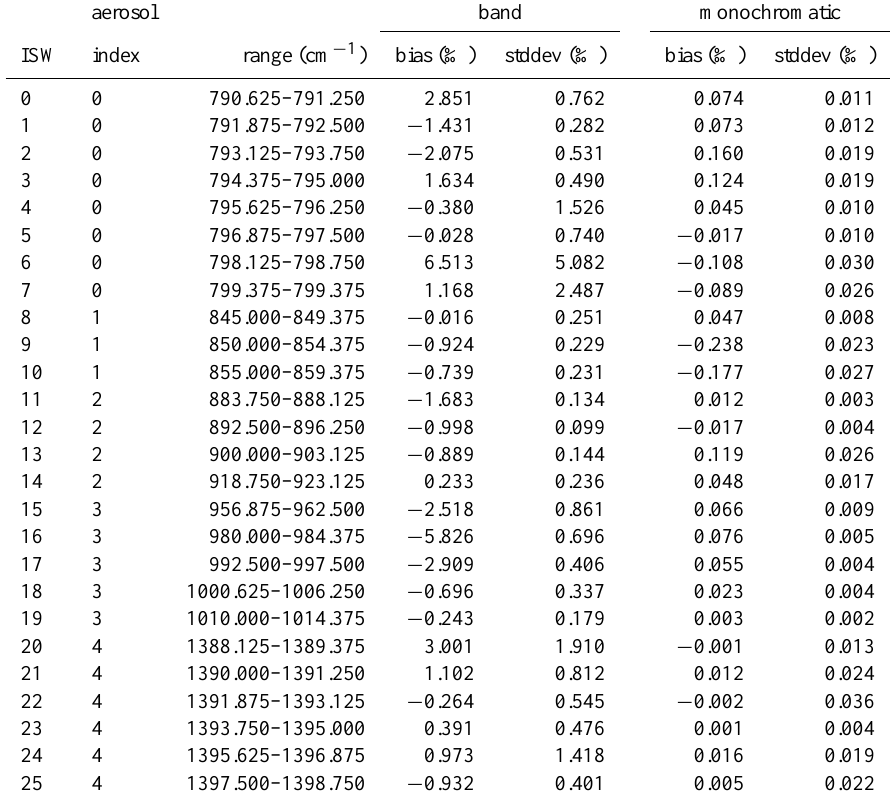
Table 2. A list of integrated spectral windows (ISW) employed and their spectral range. The last four columns shown the bias and SD of the band and monochromatic model compared to RFM.